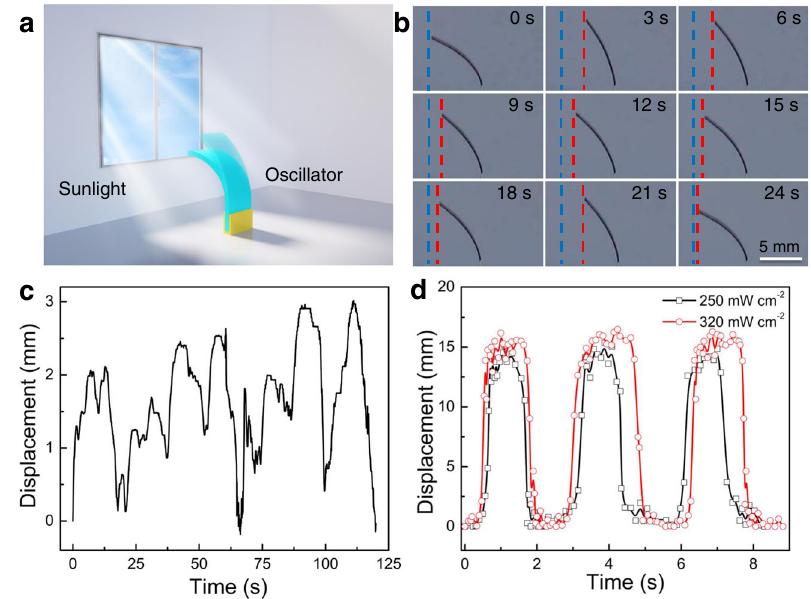
Fig. 4 | Actuation performances of the PP/CB actuator under sunlight and simulatedsunlight.a Schematicillustrationoftheoscillatingbendingactuationof the porous fi lm exposed to sunlight. b , c Photographs and displacement as a